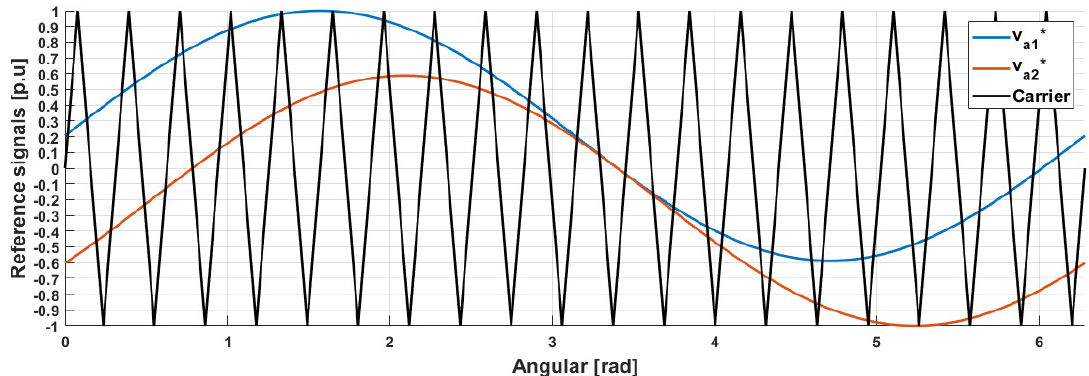
Figure 18. Carrier wave and reference voltages v ∗ and ∗ for nine-switch converters.